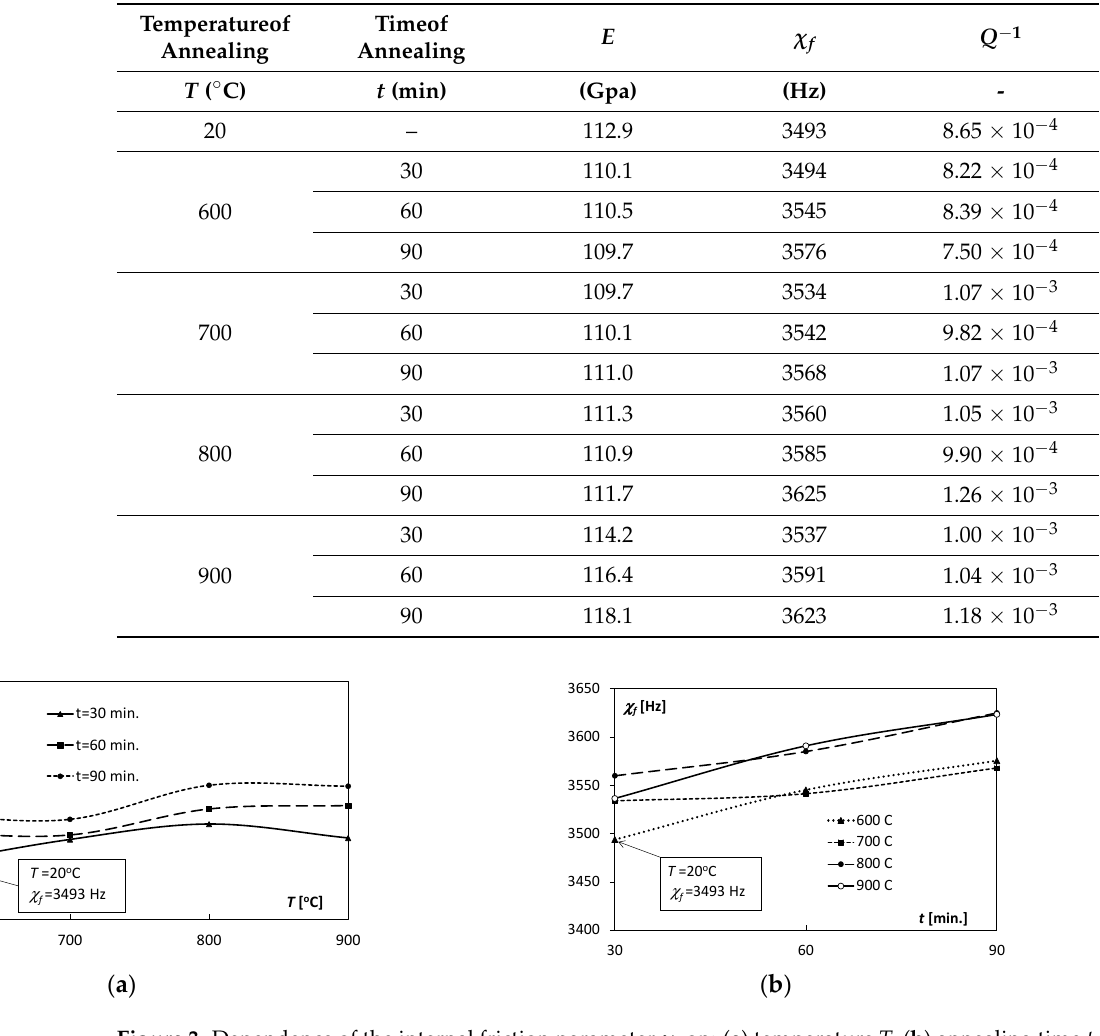
Table 2. Basic elastic properties of Ti/Cu bimetal.